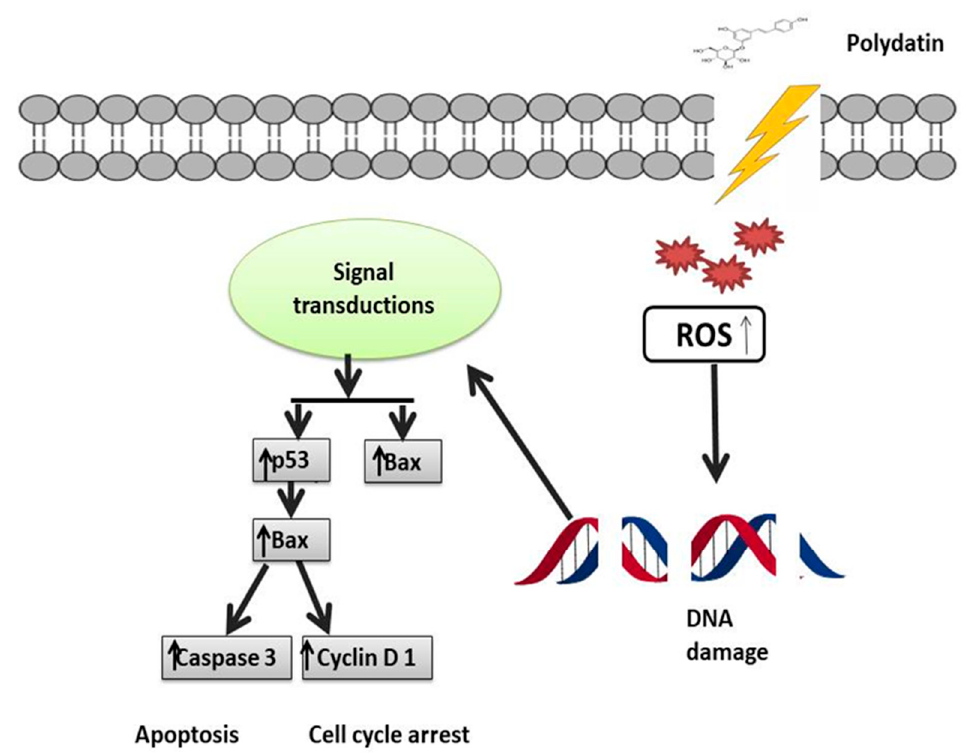
Figure 4. Mechanistic illustration of polydatin activity in the treatment of breast cancer through p53 activation. Activation of p53 leads to activation of p21 and Bax, which in turn leads to cell cycle arrest and apoptosis. ↑ Upregulation, ↓ Downregulation.